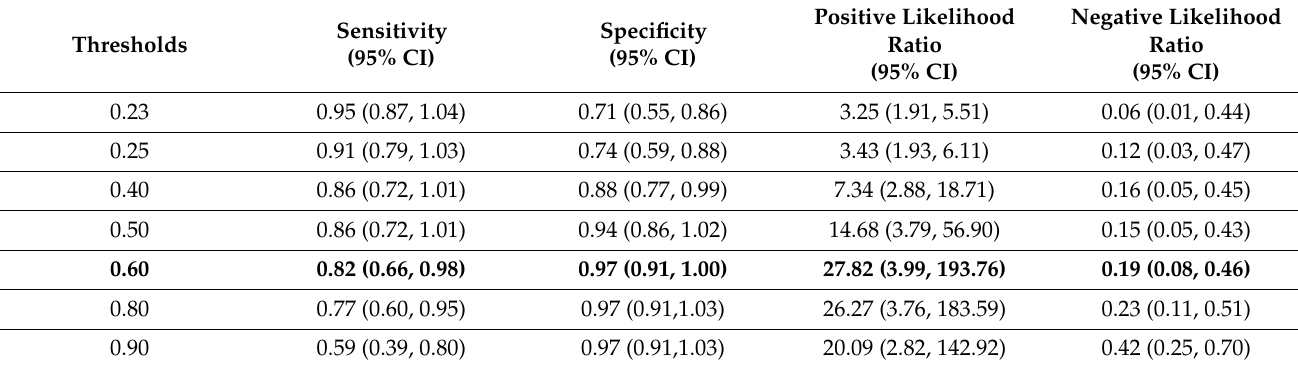
Figure 2. Percentage of symptom-error-prone (SEP) and non-symptom-error-prone (NSEP) English texts assigned by RVM with L 2 normalised SOF ( left ) and MNB with SOF ( right ) classifier to each 10% probability bin. Table 4. Probability thresholds of the best performing RVM using L 2 normalised semantic-optimised features. Bold: bold values were